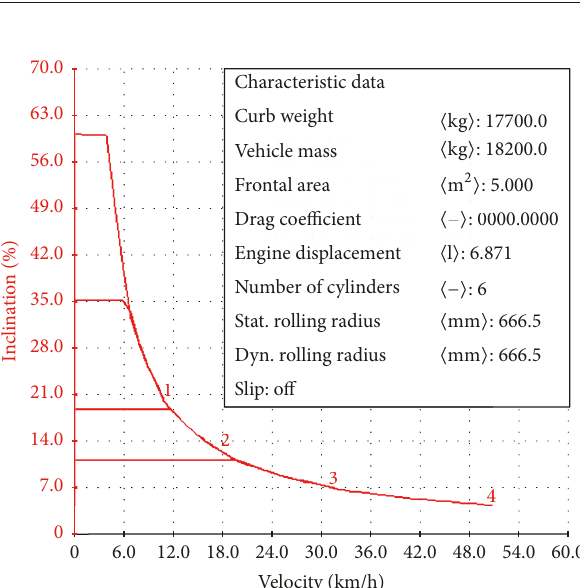
Figure 3: Climbing degree of hybrid power harvester at full